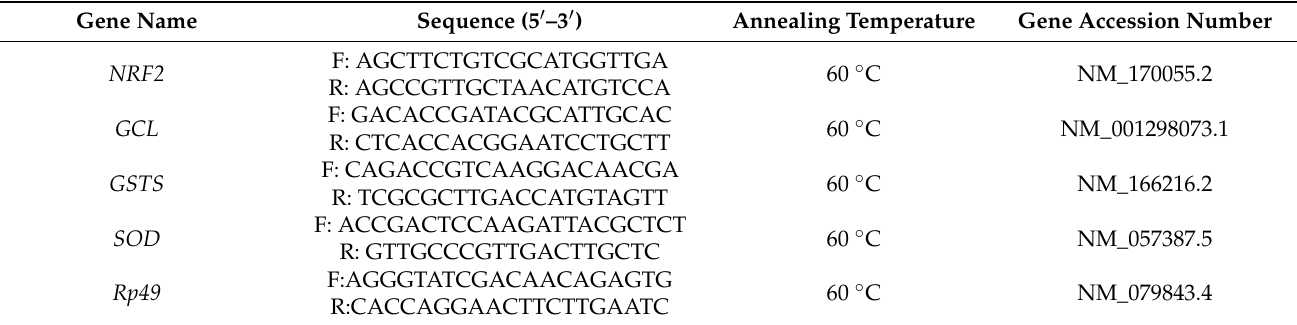
Table 1. RT–qPCR